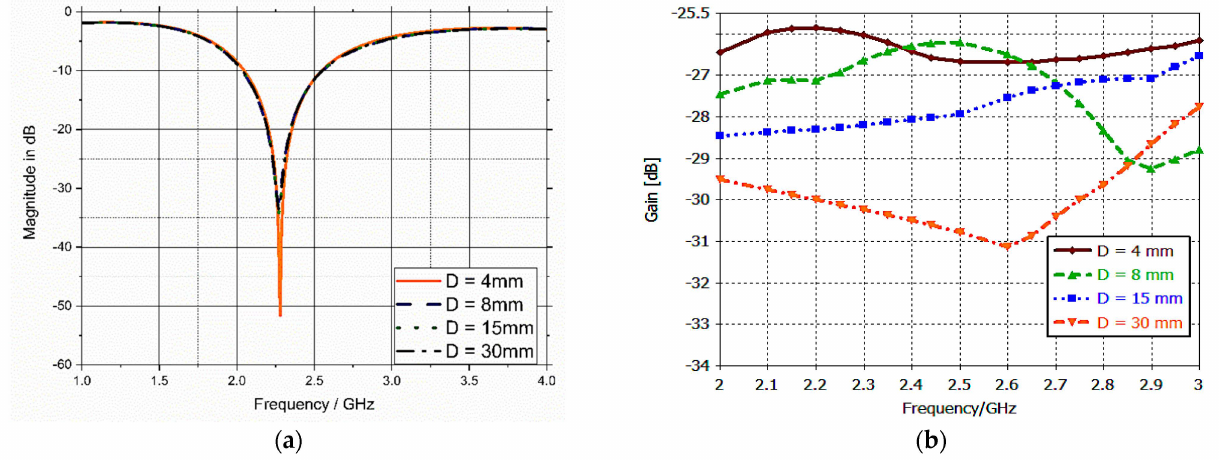
Figure 8. ( a ) S 11 parameter versus implanting depth; ( b ) gain (in dB) versus implanting